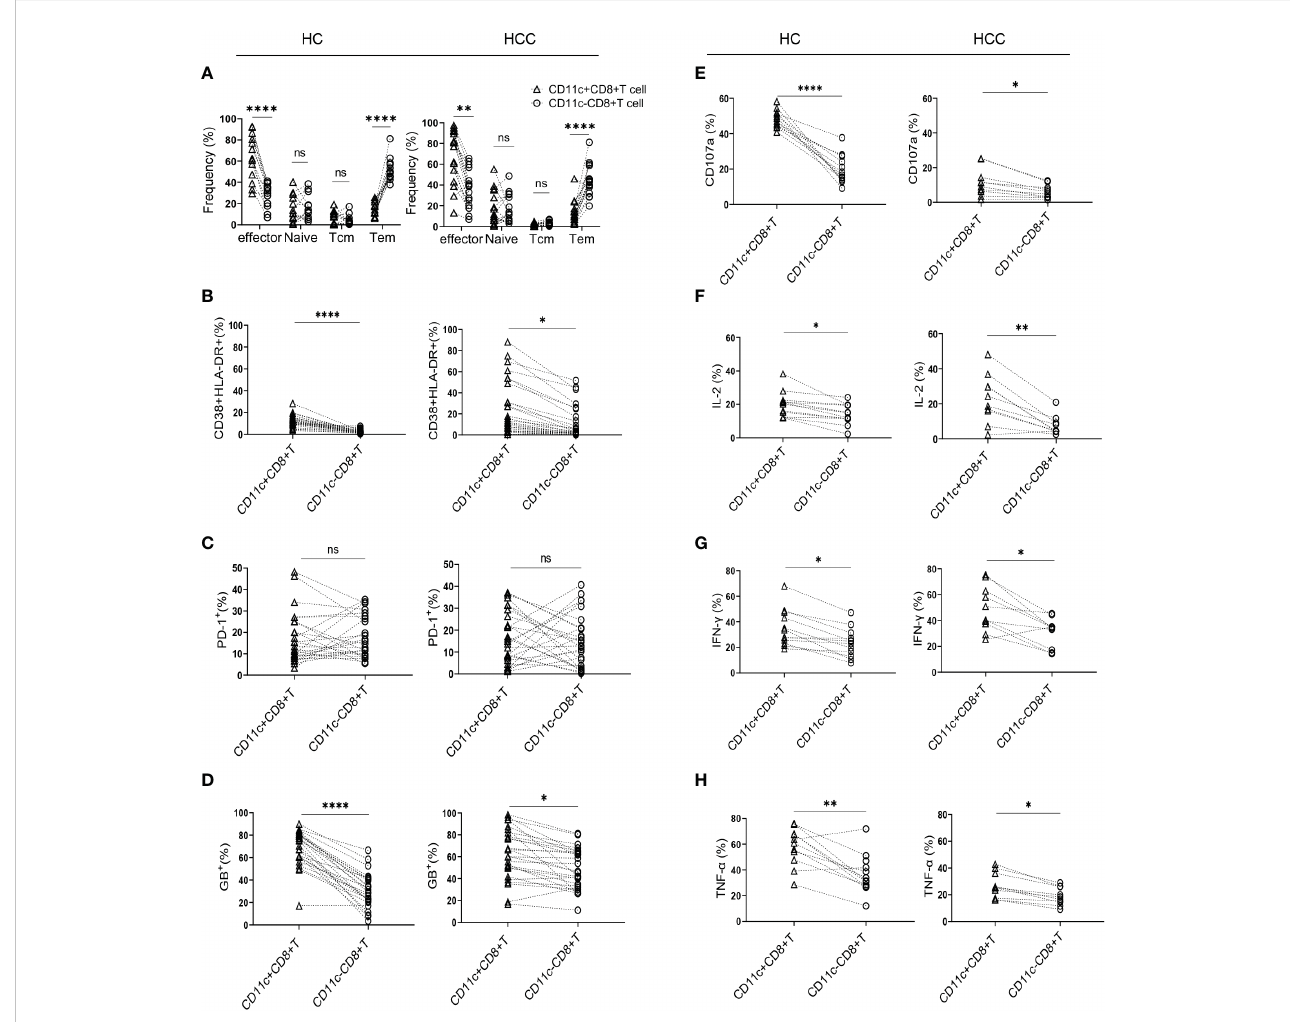
FIGURE 1 Characteristics of CD11c + CD8 + T cells in HCC and HC groups. (A) The frequency of effector memory (CCR7 - CD45RA - ) (Tem), central memory (CCR7 + CD45RA - ) (Tcm), naïve (CCR7 + CD45RA + ), and effector (CCR7 - CD45RA + ) subsets of CD11c + CD8 + and CD11c - CD8 + T cells in HCC (n = 16) and HC (n = 13) groups. (B – D) The levels of CD38 & HLA-DR, PD-1, and GB expression of CD11c + CD8 + and CD11c - CD8 + T cells in HCC (n = 26) and HC (n = 25) groups. (E – H) After PMA stimulation, the level of CD107a expression and IL-2, IFN- g , and TNF- a production of CD11c + CD8 + and CD11c - CD8 + T cells in HCC (n = 10) and HC (n = 12) groups. P values were generated using the Wilcoxon paired test between the two groups. * P < 0.05; ** P < 0.01; **** P < 0.001; ns, not signi fi